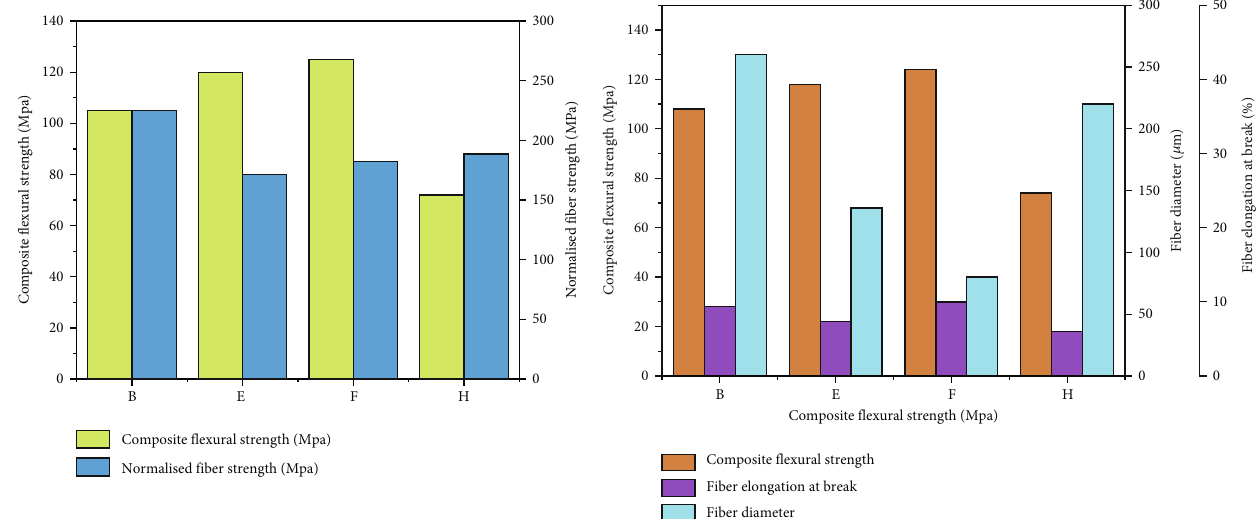
Figure 5: The e ff ect of normalised fi ber strength, fi ber elongation at break, and fi ber diameter on composite fl exural strength.